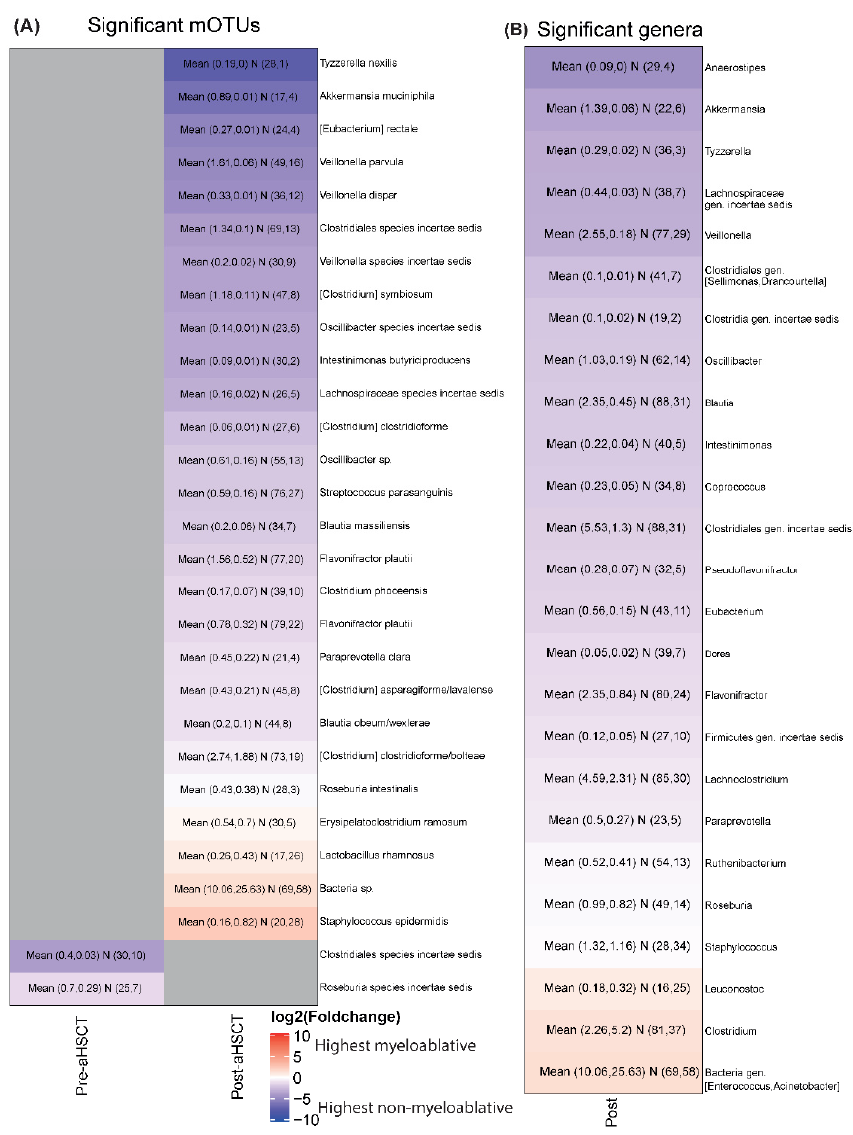
Figure 2. Taxonomic differences between conditioning regimens. ( A ) Heatmap on mOTU level of the log2 fold changes between the non-myeloablative and myeloablative groups in the pre-aHSCT and post-aHSCT sampling periods. The plot shows all mOTUs that are significantly different in at least one comparison using our discovery method. Gray means not significant. Blue colors show that the mean abundance of an mOTU is higher in the non-myeloablative group than in the myeloablative group and red shows the opposite direction. The text in the cells shows “Mean (mean (non-myeloablative), mean (myeloablative)) N (number of non-myeloablative samples with the mOTU present, number of myeloablative samples with the mOTU present)”. The total number of samples are pre-aHSCT myeloablative = 67, pre-aHSCT non-myeloablative = 104, post-aHSCT myeloablative = 76, post-aHSCT non-myeloablative = 116. ( B ) The same plot as A but on genus level. Only the post period is shown as no genera differed in the pre-aHSCT